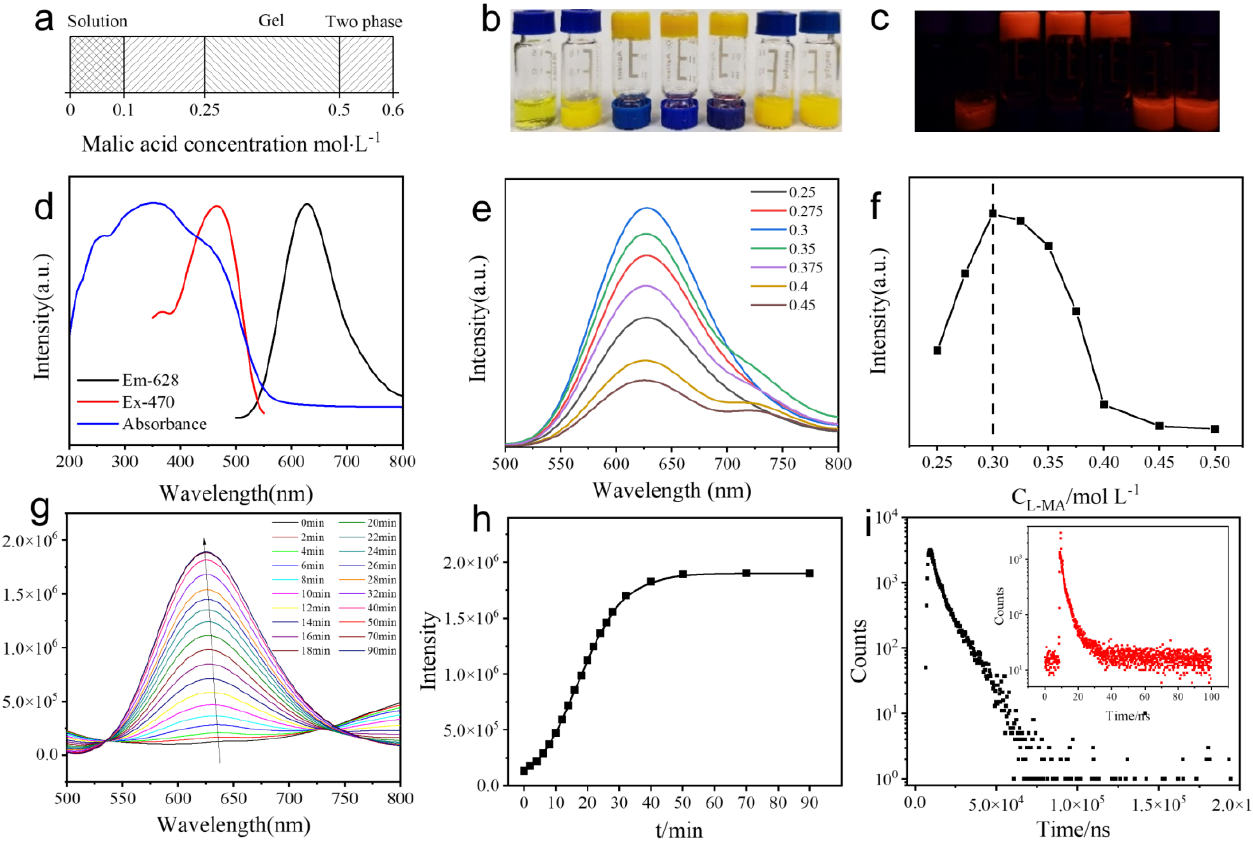
Figure 1. ( a ) Phase transition with different concentration of L–MA. ( b ) Photographs of the hydrogels with different L–MA concentrations. ( c ) Fluorescence photographs of the hydrogels with different L–MA concentrations. ( d ) Photoexcitation (red line, emission = 628 nm), photoemission (black line, excitation = 470 nm) spectra of Ag 9 -NCs hydrogels, and UV–vis absorption (blue line). ( e ) Photoluminescence (PL) spectra of hydrogels with different concentration of L–MA for excitation at 470 nm. ( f ) Comparison of the luminescence intensity of hydrogels with different concentration of L–MA at 628 nm. ( g ) PL spectra of Ag 9 -NCs hydrogels with different incubation times for excitation at 470 nm. ( h ) Comparison of the luminescence intensity of hydrogels with different incubation times. ( i ) PL decay profiles of Ag 9 -NCs hydrogel. Inset: the PL decay profiles of the powder of lyophilized Ag 9 -NCs solution.